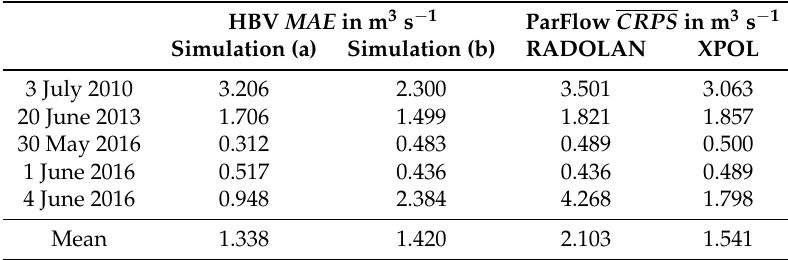
Figure 6. HBV validation results, where P is the precipitation in mm h − 1 and Q is the discharge in m 3 s − 1 . Simulation (a) is based on a single calibration without all five events, whereas simulation (b) is based on calibrations for each event individually. ParFlow results aggregated from 5-min to hourly timesteps are included for reference. RAD and XPol denote the different ParFlow QPE forcings. Table 6. HBV and ParFlow ensemble